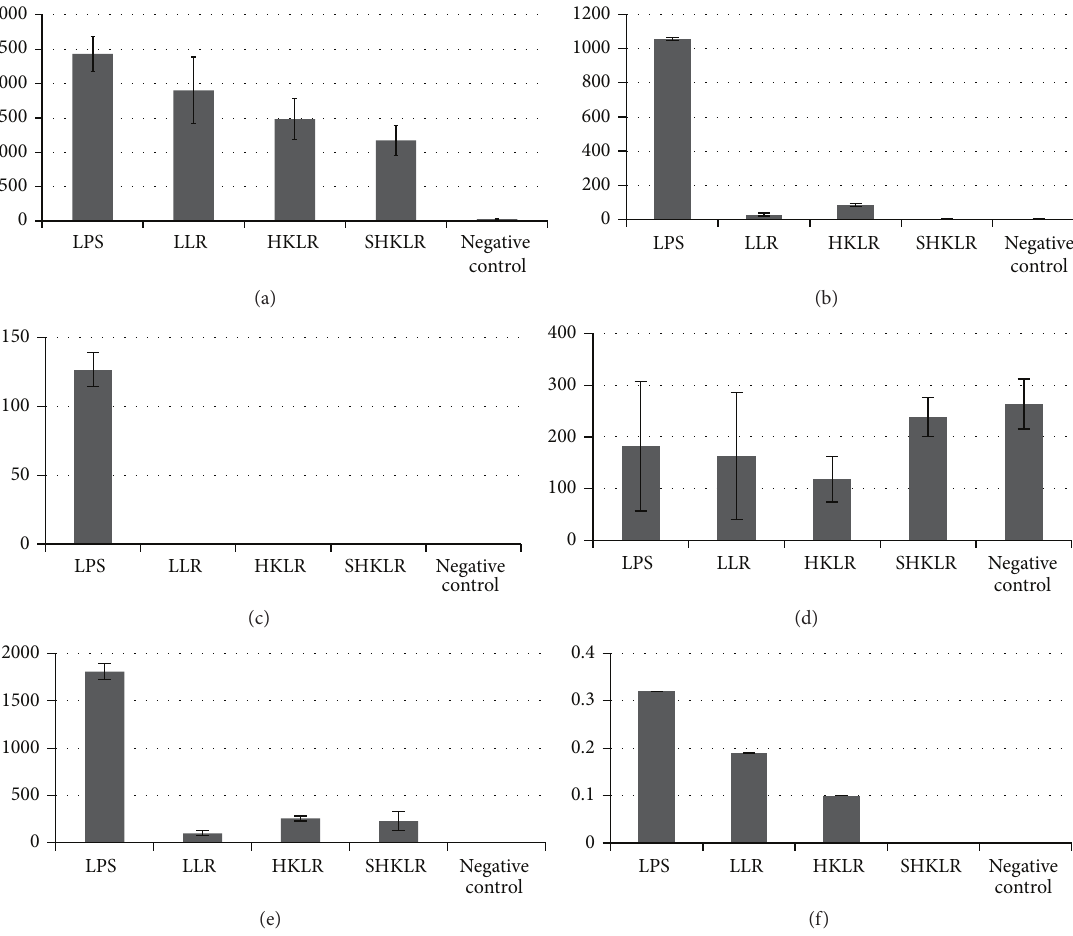
Figure1:Cytokinessecretedbymacrophagesafterexposuretodifferentsuspensions:LPS(positivecontrol);negativecontrol(salinesolution); LLR: live L . rhamnosus ; HKLR: heat-killed L . rhamnosus ; and SHKLR: supernatant of heat-killed L . rhamnosus . Mean values (pg/mL)